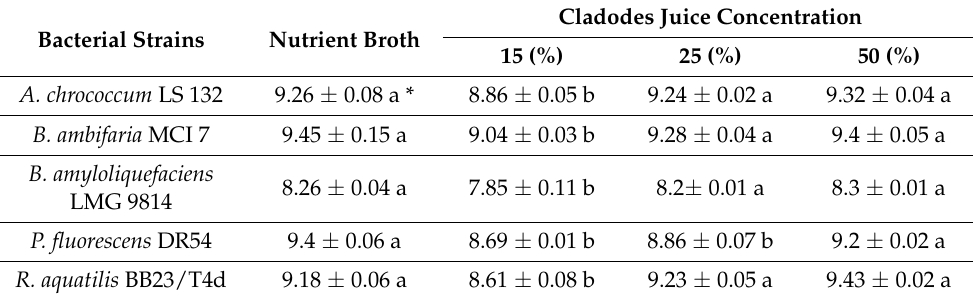
Table 3. Determination of viable cells (Log CFU mL − 1 ) after 16–18 h of bacterial culture on nutrient broth and three different cladodes juice concentrations in shaken flasks. Bacterial Strains Nutrient